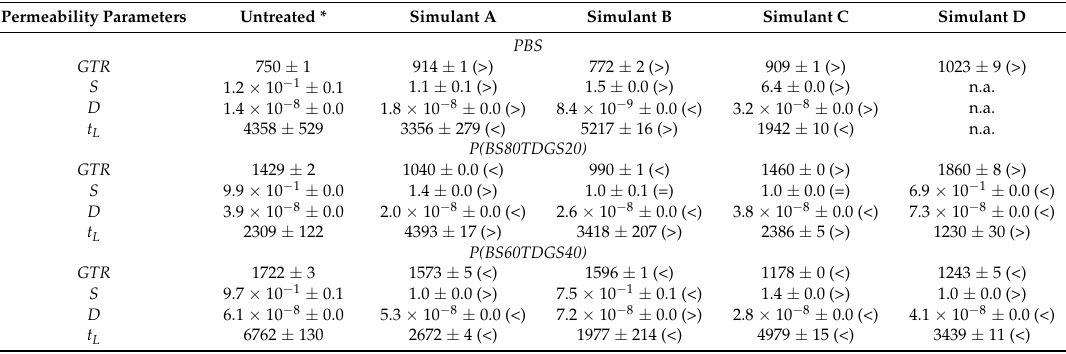
Table 9. GTR , S , D , and t L data for CO 2 gas test, after food simulant contact GTR ( cm 3 / cm 2 day bar ), S